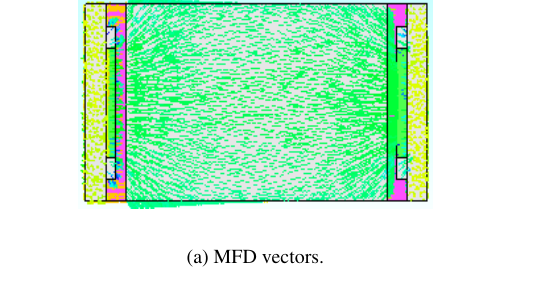
Figure 8: Proposed pick-up structure. posed to accommodate battery cell charging and shown to induce three orthogonal field components.